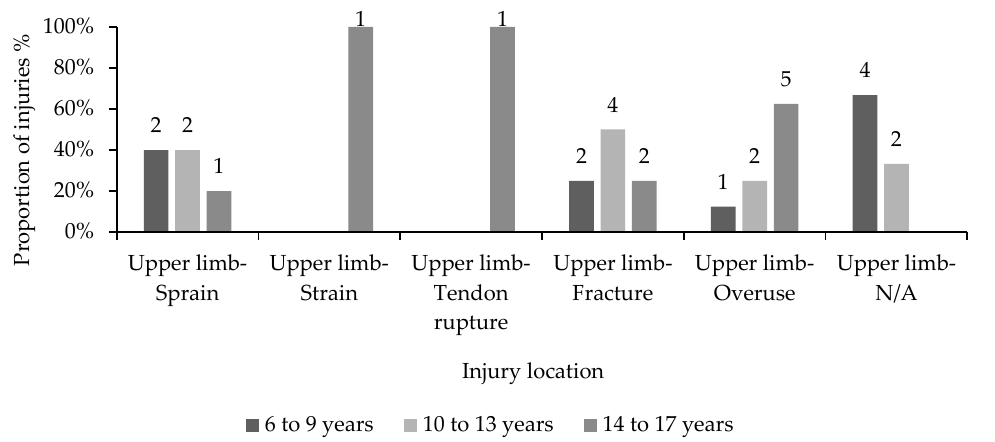
Figure 3 . Proportions of diagnosed upper limb injury types distributed across three age categories. Figure 3. Proportions of diagnosed upper limb injury types distributed across three age